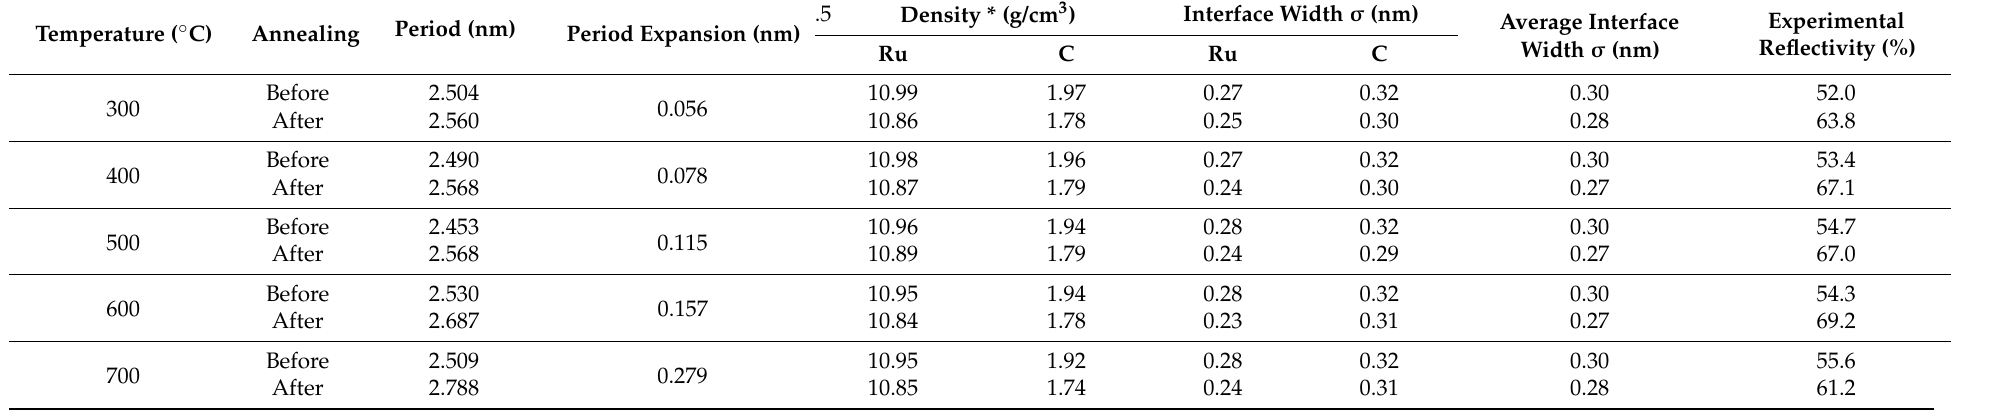
Table 1. Detailed fitting structural parameters of Ru/C multilayers measured before and after